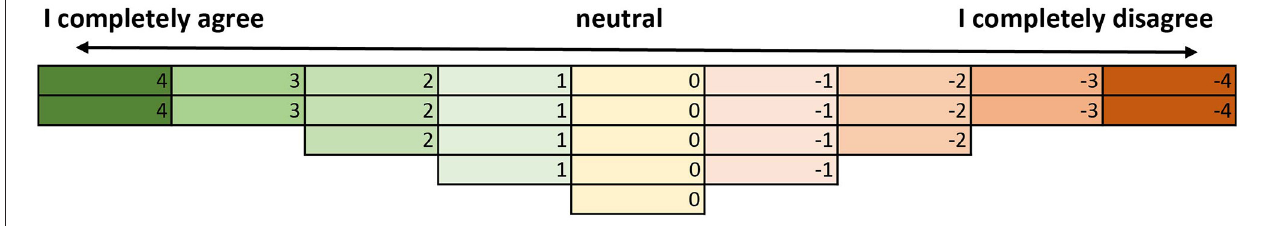
FIGURE 2 | Ranking scale for the